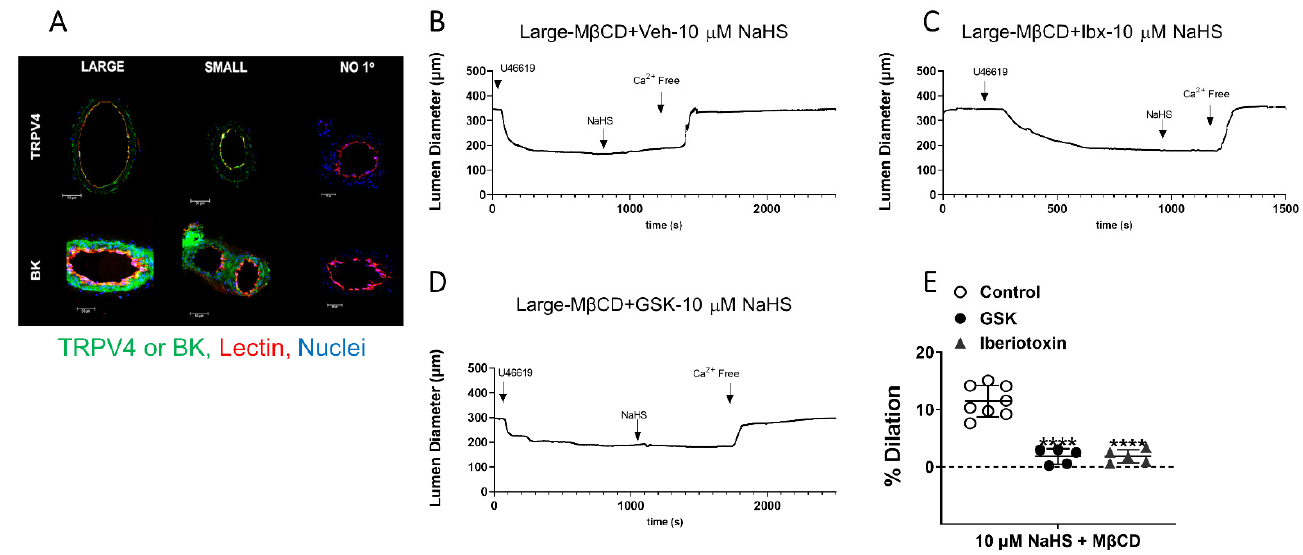
Figure 4. H 2 S-induced vasodilation following cholesterol reduction in large arteries is mediated by activation of TRPV4 and BK channels. ( A ). Representative images of EC PM TRPV4 and BK (green), endothelial glycoprotein marker Lectin (red) in cross-sections of large and small mesenteric arteries. Nuclei are labeled with SYTOX (blue). “NO 1 ◦ ” shows the no primary Ab negative controls. Representative traces and data summary of H 2 S-mediated vasodilation following cholesterol reduction ( B ) in large arteries in the presence of BK inhibitor iberiotoxin (( C ), Ibtx, 100 nM) or TRPV4 inhibitor GSK 2193874 (( D ), GSK, 300 nM) Summary data of H 2 S-induced dilation in